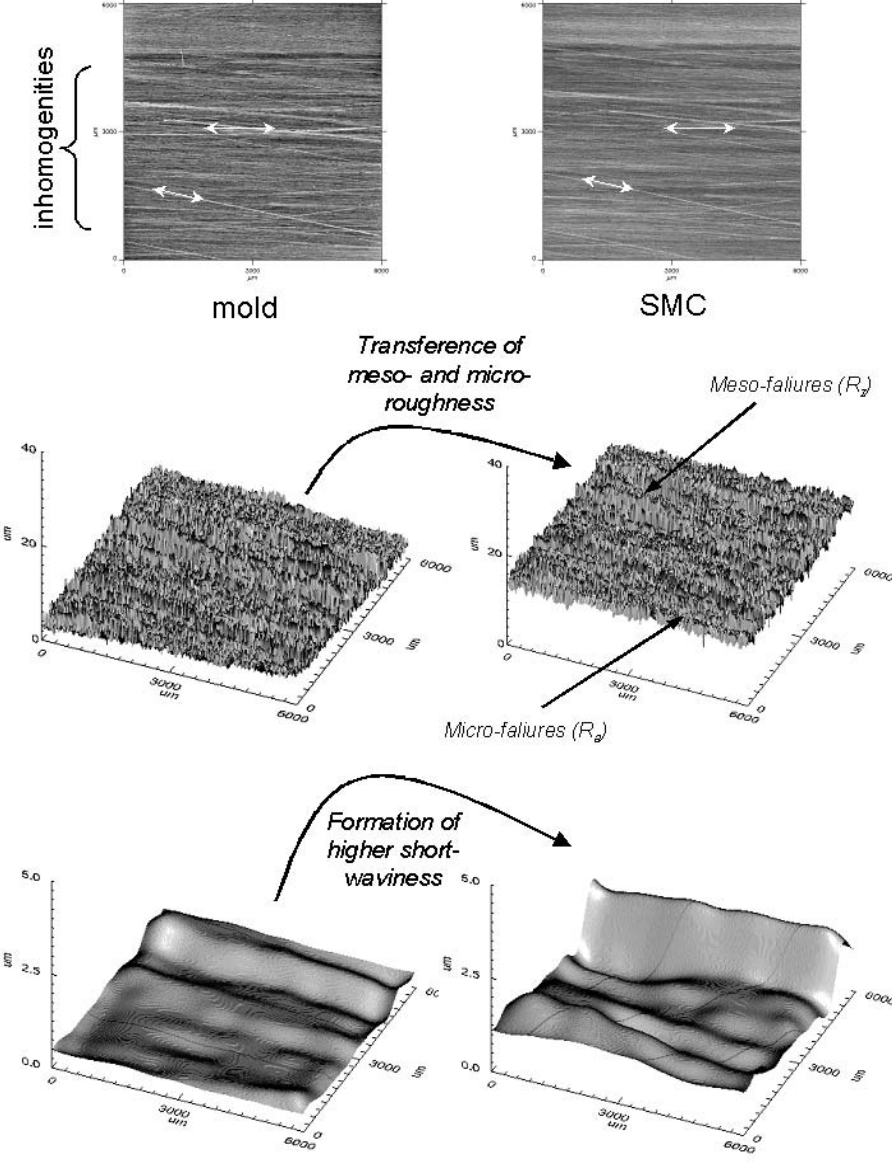
Figure 13. Transfer of meso- and micro morphologies from mould to SMC